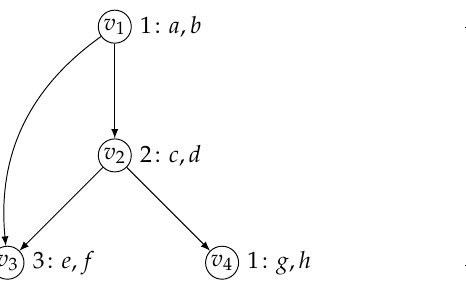
: A v of Example 1. The A v A v 2 → 3 1 × 3 ( ad ) = f 3